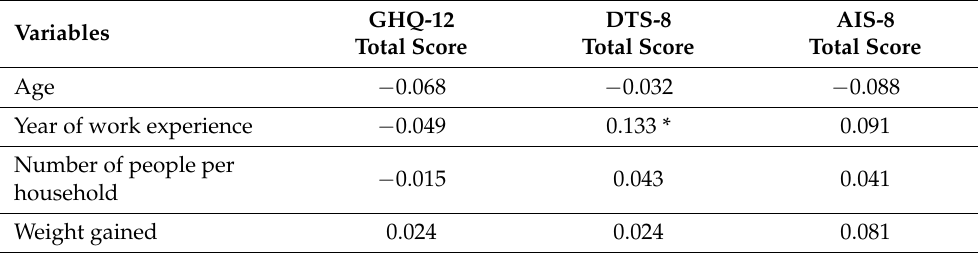
Table 5. Inferential analysis: Pearson’s r correlation